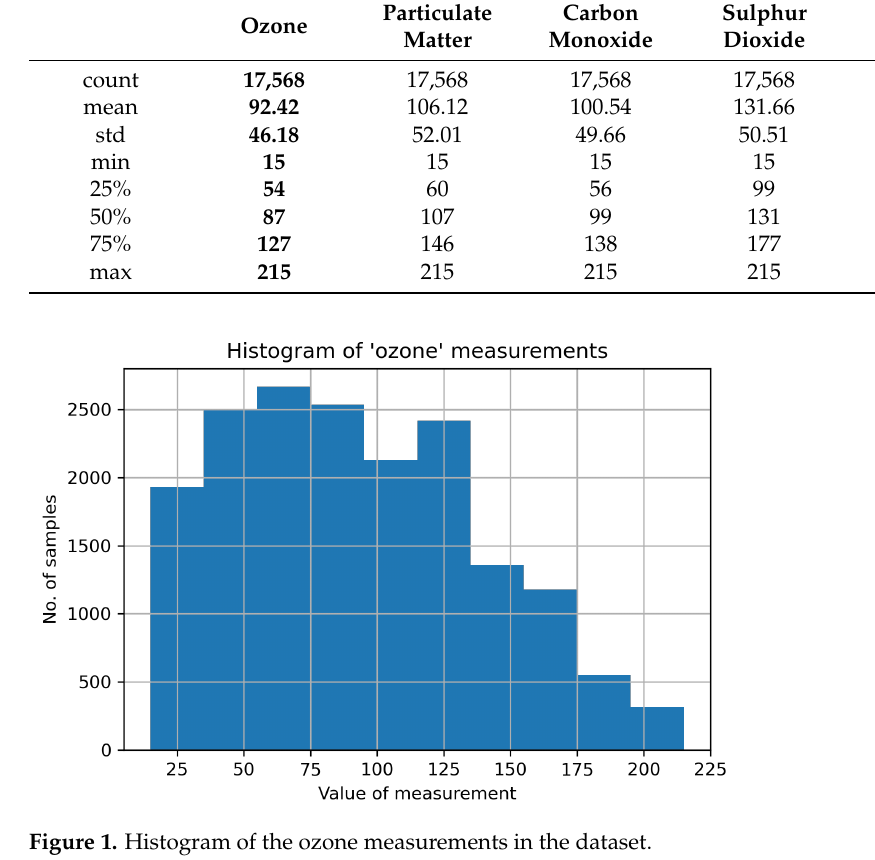
Figure 1. Histogram of the ozone measurements in the